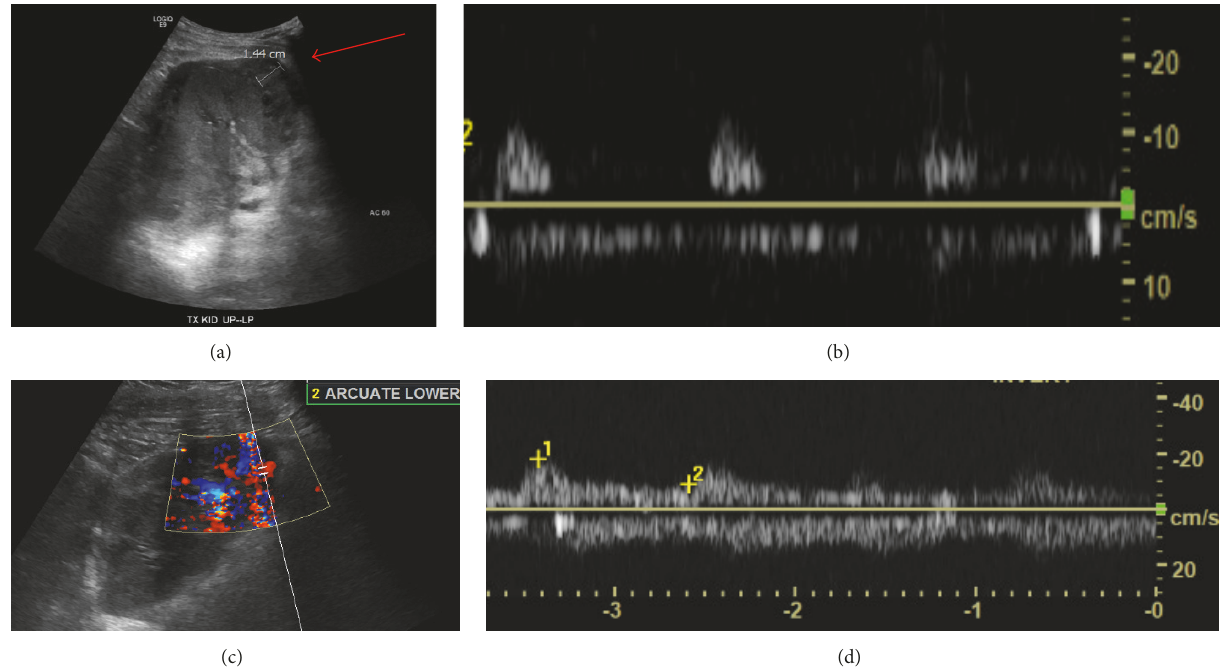
Figure 1: (a) Preprocedure renal transplant ultrasound demonstrating subcapsular hematoma (arrow). (b) Arcuate waveforms from the inferior pole with RI = 1.0 prior to operative decompression. (c) Renal transplant ultrasound after capsulotomy and clot evacuation, demonstrating restoration of inferior pole perfusion with (d) normalization of arcuate artery RI to